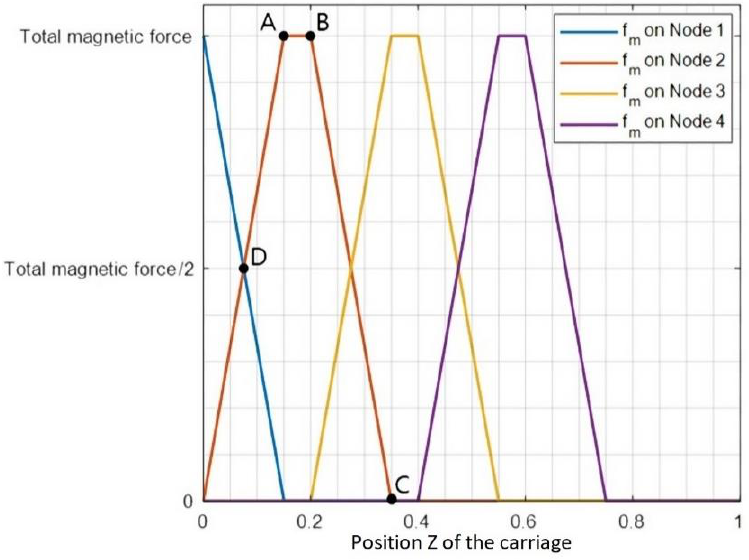
Figure 5. Functions of the magnetic force.